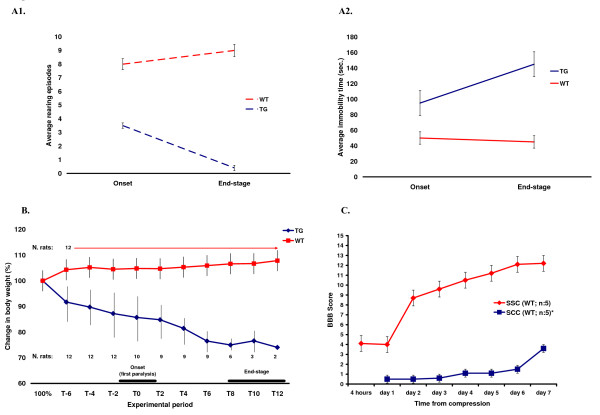
Graphs illustrating the profiles of functional, behavioural and weight changes recorded in the models of trauma and genetically-induced spinal cord degeneration employed in this study. The functional and behavioural analyses include the open-field locomotor assessment (BBB score) of rats after mild spinal cord compression and the evaluation of immobility time and rearing episodes in G93A SOD1 mutant rats. For comparison, we report previously published data generated from similar experimental platforms (data taken from Jokic et al. 2007 and Huang et al. 2007) [16,18]. A1 – A2: Schematic representation of the average immobility time (A2) and average number of rearing episodes (A1) observed in 4 G93A SOD1 mutant rats with subtle signs of hindlimb paralysis at disease presentation and in 4 wild type rats. Determinations by independent observers were performed at onset and at end-stage disease, based on 2 subsequent 3-minutes video clips recorded during disease development in the 4 G93A SOD1 mutant rats and in the WT littermates. Data previously reported by Jokic et al. [16]. At disease onset, the duration of average immobility time in the wild-type and in the G93A SOD1 mutant animals was similar, whereas a significant increase in duration of immobility time was observed in the G93A SOD1 mutant animals at end stage disease (A2; p < 0.05, ANOVA). A remarkable reduction of rearing episodes is seen in G93A SOD1 mutant rats at end-stage disease (A1; p < 0.001, ANOVA). Disease onset (appearance of first signs of paralysis): 129 +/- 17.3 days. End-stage disease (25–30% loss of body weight): 139 +/- 17 days. B: Individual body weight measurements of 12 G93A SOD1 mutant rats and of 12 age-matched wild type animals from a pre-symptomatic stage to end-stage disease (G93A SOD1 mutant rats presented with either hindlimb or forelimb paralysis at disease onset). The data presented include previous observations obtained from a group of 4 G93A SOD1 mutant rats and 4 wild type rats [16]. The maximum body weight recorded for each G93A SOD1 mutant rat was set at 100% as base-line. The graph indicates body weight measurements performed after this point (the measurements started at 7 weeks of age and were performed every two days), expressed as percentage of the maximum body weight. Disease onset (T0) is indicated at the time of the appearance of the first signs of paralysis (on average at 129 +/- 17.3 days of age). At disease onset, weight loss has been progressing for at least 6 days to a 10 to 15% reduction from maximum body weight. The end-stage disease was set at 25–30% of weight loss (139 +/- 17 days of age in the G93A SOD1 mutants). Weight measurements are expressed as averages of weight determinations of the number of surviving animals reported in the graph (those rats reaching a 25–30% body weight reduction were sacrificed). The graph reports the numbers of surviving animals at each time point. C: the graph illustrates the functional recovery of wild-type female rats after spinal cord compression, measured at 30 minutes, 4 hours, 24 hours and 7 days from mild injury (35 g weight spinal cord compression) using the Basso, Beattie, and Bresnahan (BBB) open-field locomotor assessment. The BBB scoring for each 5 animals right and left hindlimb was graded at the defined time points by two independent blinded observers (red colour code). Also plotted are the BBB scores of Sprague-Dawley rats after a 50 g compression injury (blue colour code, n: 5), taken from previously reported data [18].